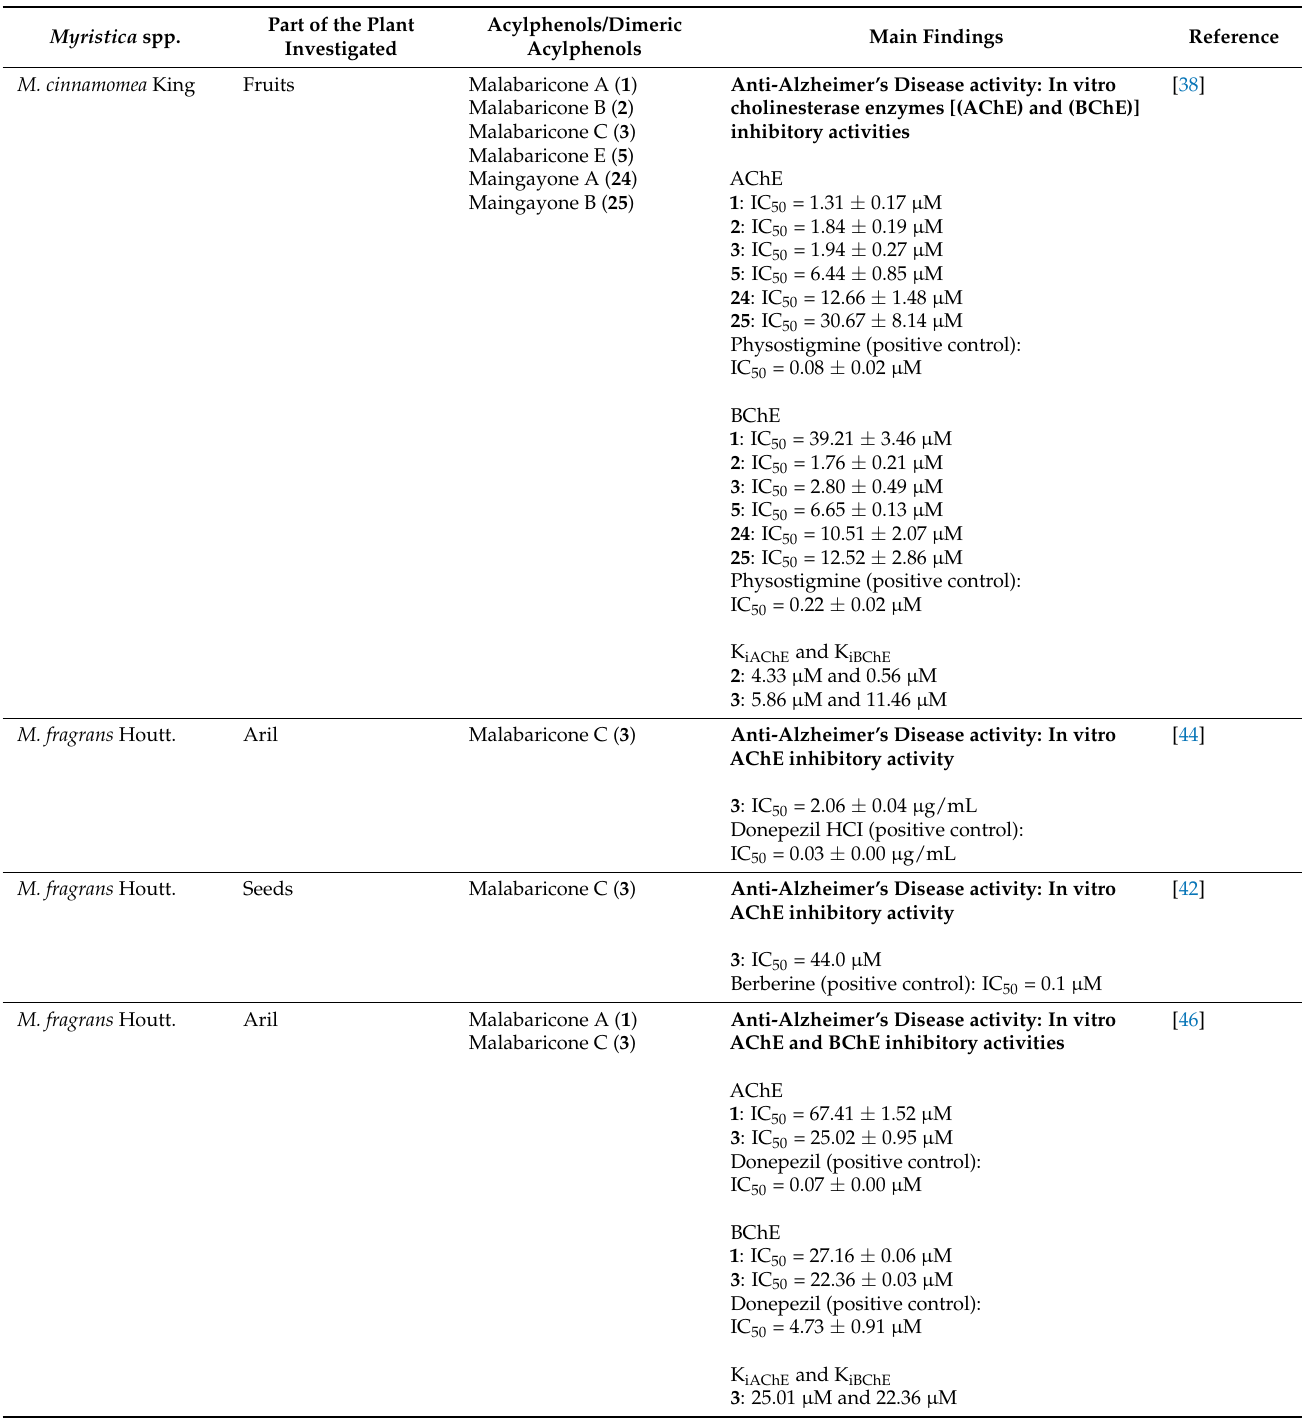
Table 8. The anti-Alzheimer’s Disease activity of acylphenols and dimeric acylphenols from the genus Myristica